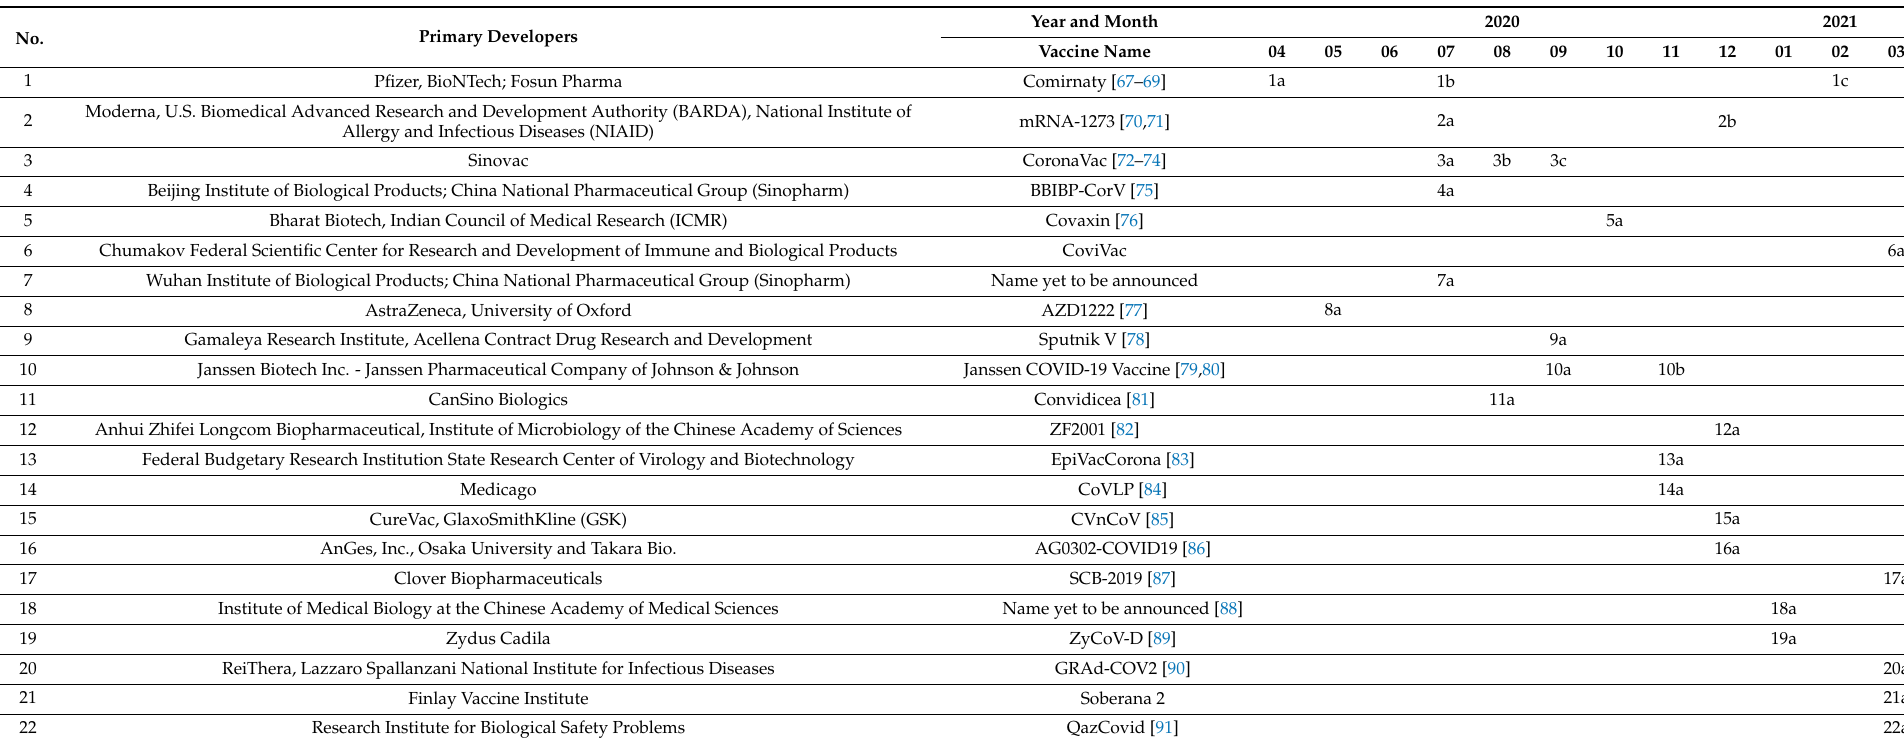
Table 1. Timeline of phase III clinical trials of leading vaccines up to March 2021. Specific codes, i.e., 1a, 1b, etc., are assigned to each registered clinical trial where the details and findings are tabulated in Table S1 under the supplementary